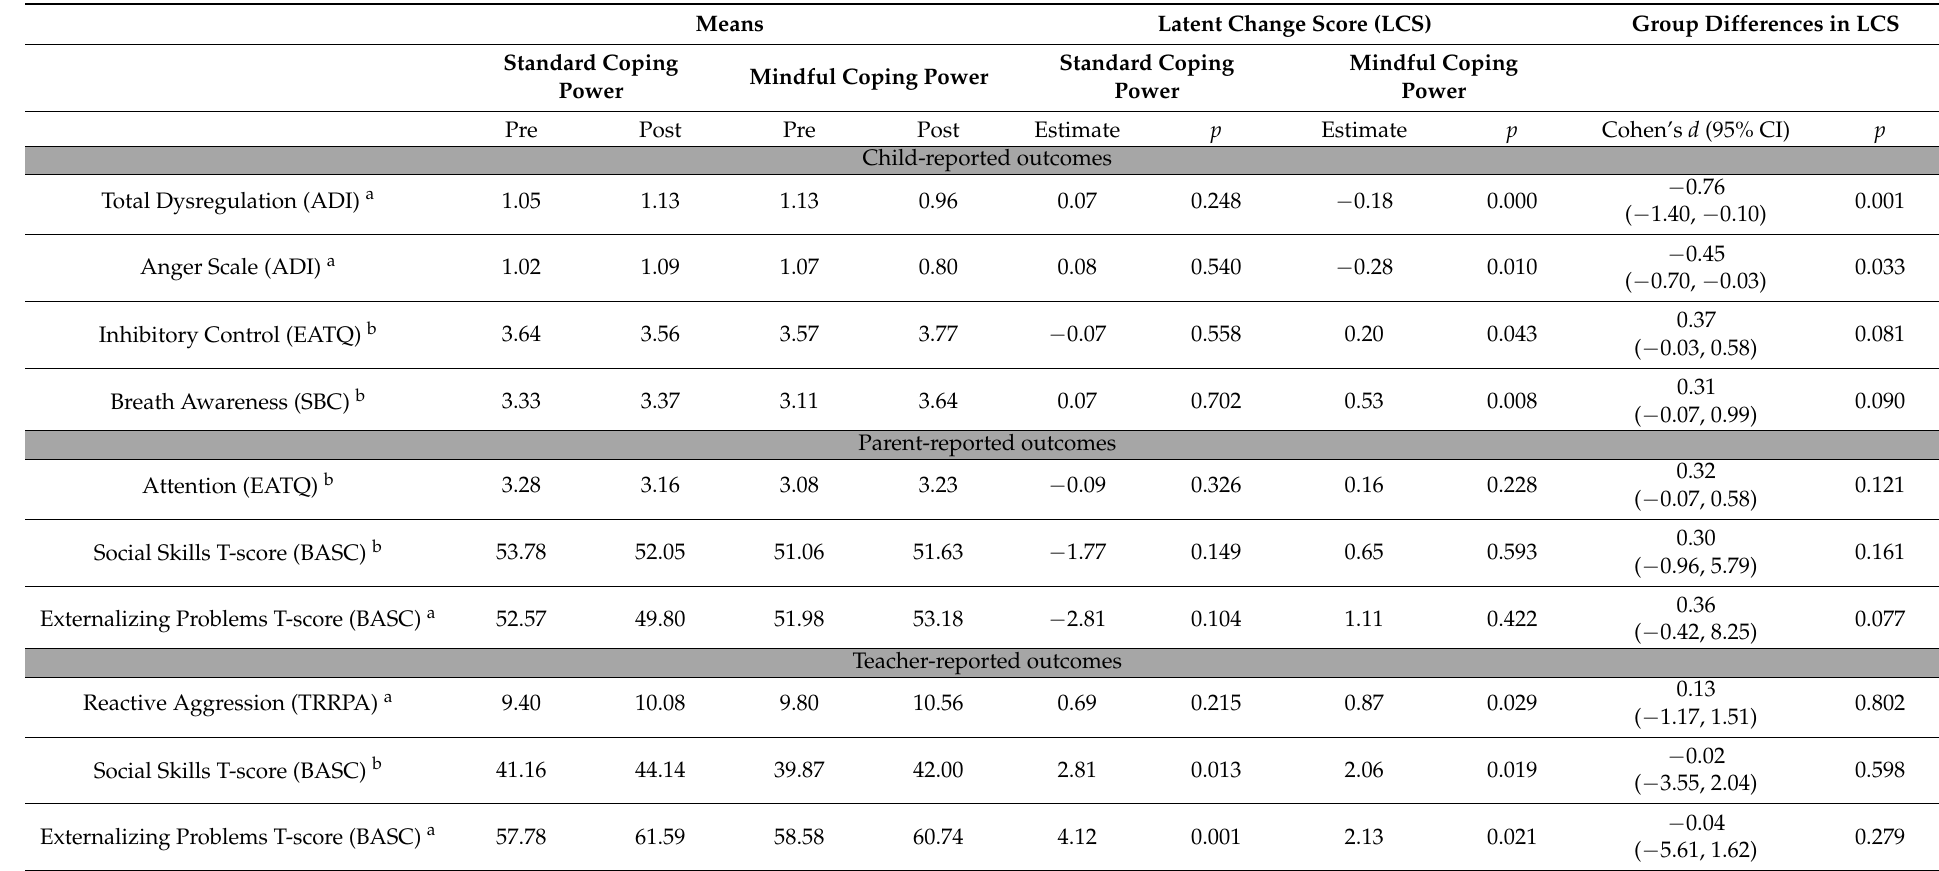
Table 2. Comparative effects of standard Coping Power (CP) and Mindful Coping Power (MCP) on child outcomes in a pilot randomized trial. Means Latent Change Score (LCS) Group Differences in LCS Standard Coping Standard Coping Mindful Coping Mindful Coping Power Power Power Power Pre Post Pre Post Estimate p Estimate p Cohen’s d (95% CI)